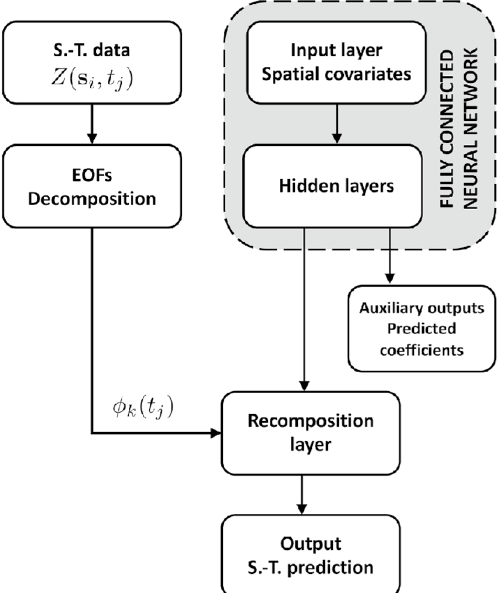
Figure 1. The architecture of the proposed framework. The temporal bases are extracted from a decomposition of the spatio-temporal signal using EOFs. Then, a fully connected neural network is used to learn the corresponding spatial coefficients. The full spatio-temporal field is recomposed following Eq. (1) and used for loss